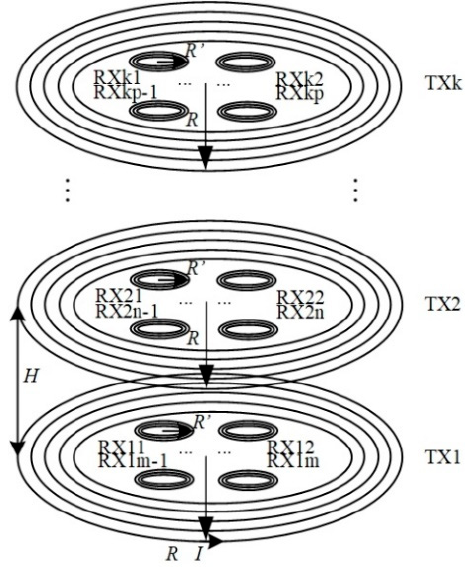
Figure 4. The structure of the proposed WPT system.